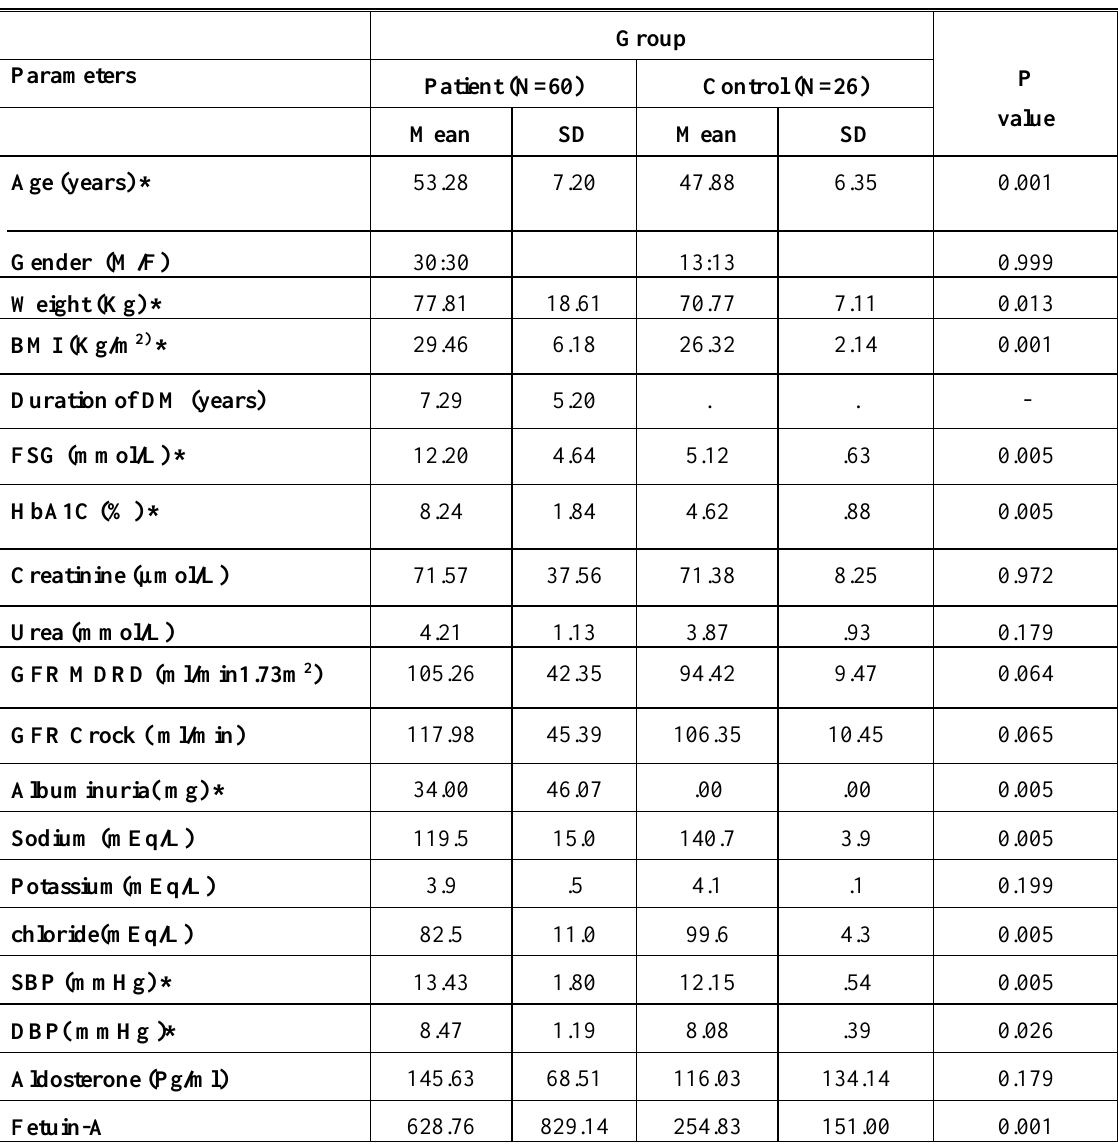
Table (1) Subject